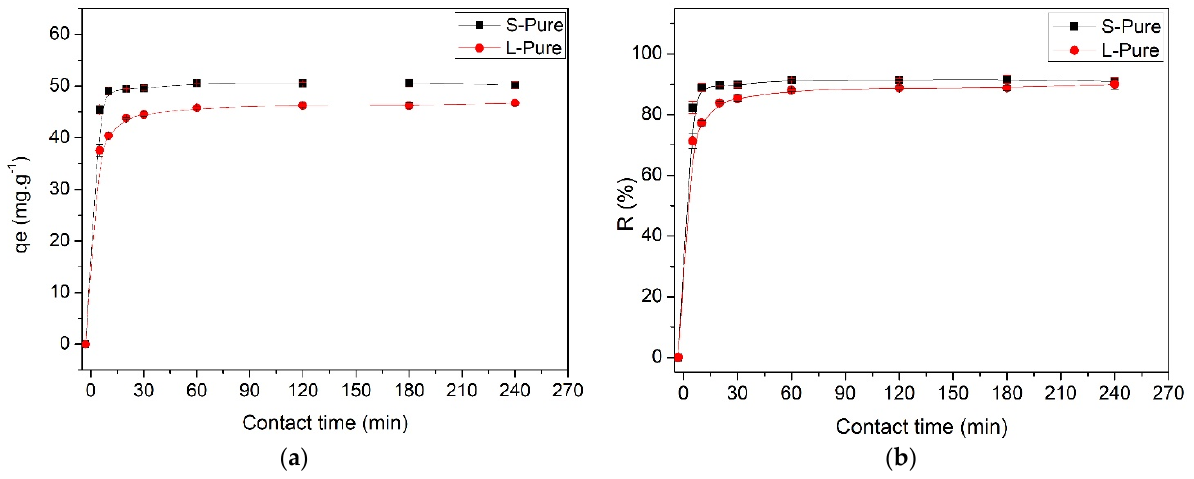
( b ) Figure 3. ( a ) Relation between the amount of dye adsorbed as a function of pH and ( b ) adsorption efficiency. It is evident that the water hyacinth as a raw material for the constitution of bioadsorbents has natural advantages, such as a spongy structure with large cellular gaps, which can generate a significant specific surface area. In general, the greater the specific surface area of the biomass, the greater the pore volume, which can provide greater adsorption capacity [64]. Its surface presents a slightly more basic character, indicating that it can adsorb cationic dyes more easily in a certain pH range, but it also includes some acidic characteristics, indicating the presence of different active sites on its surface. This can be explained by the fact that S-Pure and L-Pure have adsorption capacities at pHs 3